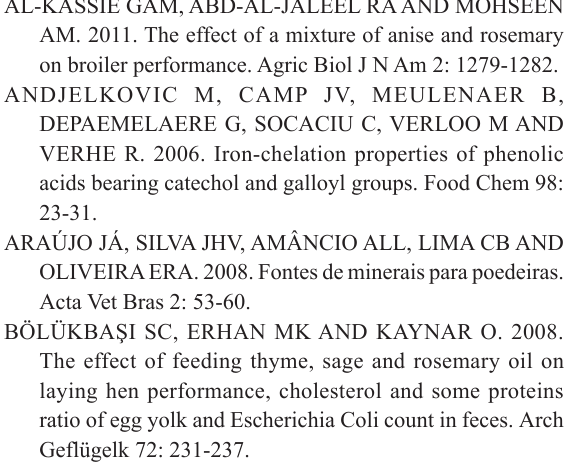
Different lowercase letters in the same column and uppercase letters in the same row are significant at 1%